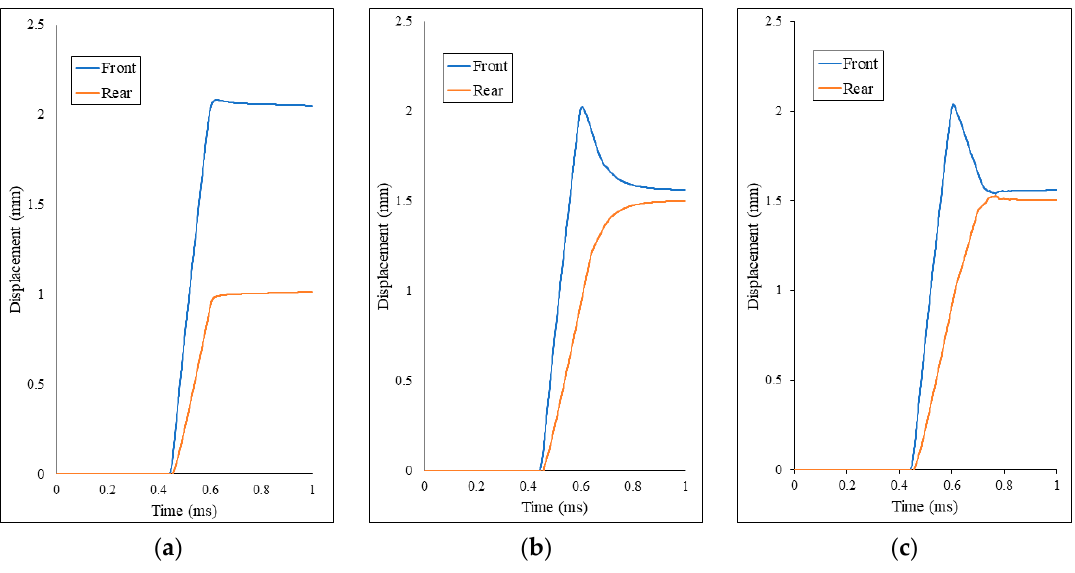
Figure 17. Change of specimen’s flat side displacement: ( a ) base model, ( b ) HU = 0, ( c ) HU = 1.